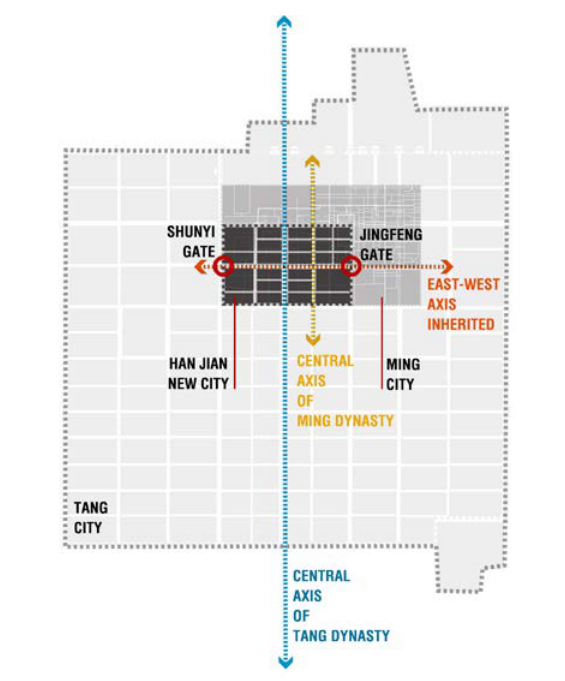
Figure 3. The inheritance of Chang'an City